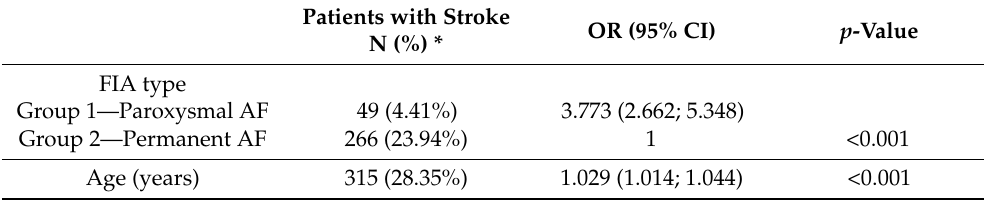
Table 7. Multiple logistic regression analysis for risk of stroke after AF diagnosis for AF type and